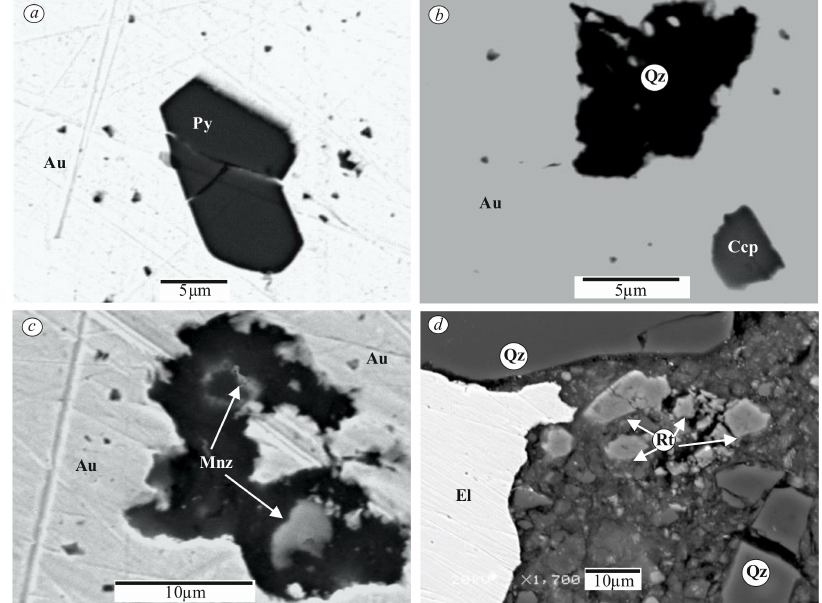
Figure 5. Mineral inclusions in placer gold from the Ulakhan Khaptasynnakh Creek: ( a ) pyrite (Py) crystal; ( b ) quartz (Qz) and chalcopyrite (Ccp) inclusions; ( c ) small monazite (Mnz) crystals; ( d ) rutile (Rt) and quartz (Qz) grains in electrum. Images have been taken in BSE mode. Conventional symbols of minerals have been taken from